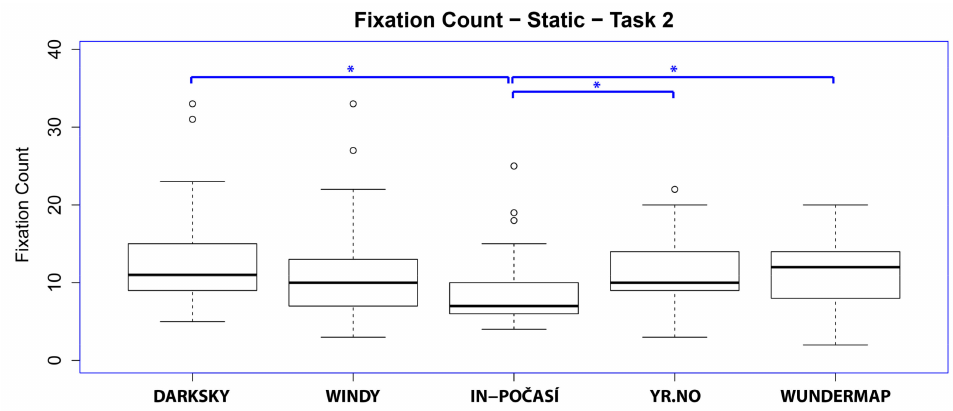
Figure 16. Fixation Count analysis in the Static Section—Task 2.